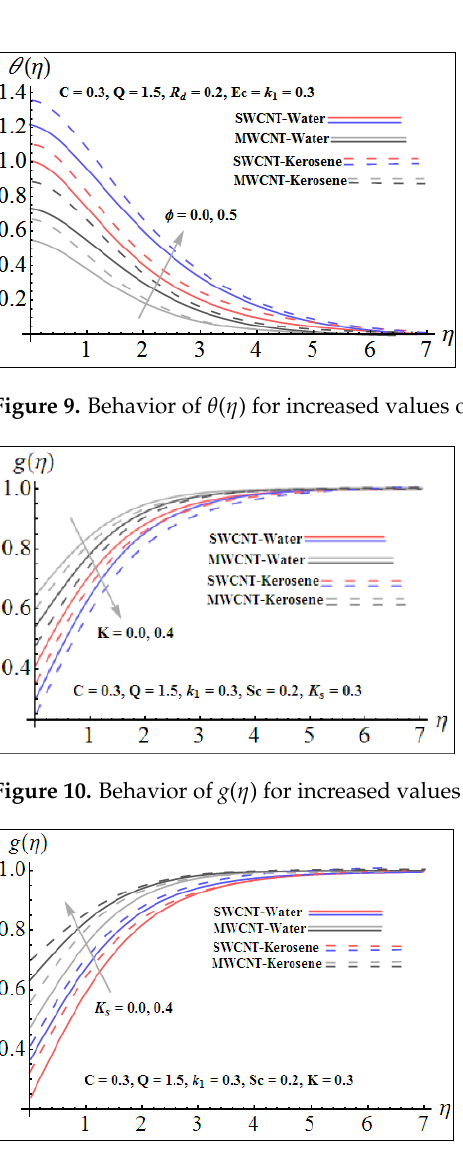
Figure 8. Behavior of θ ( η ) for increased values of 𝑅 (cid:3031) .